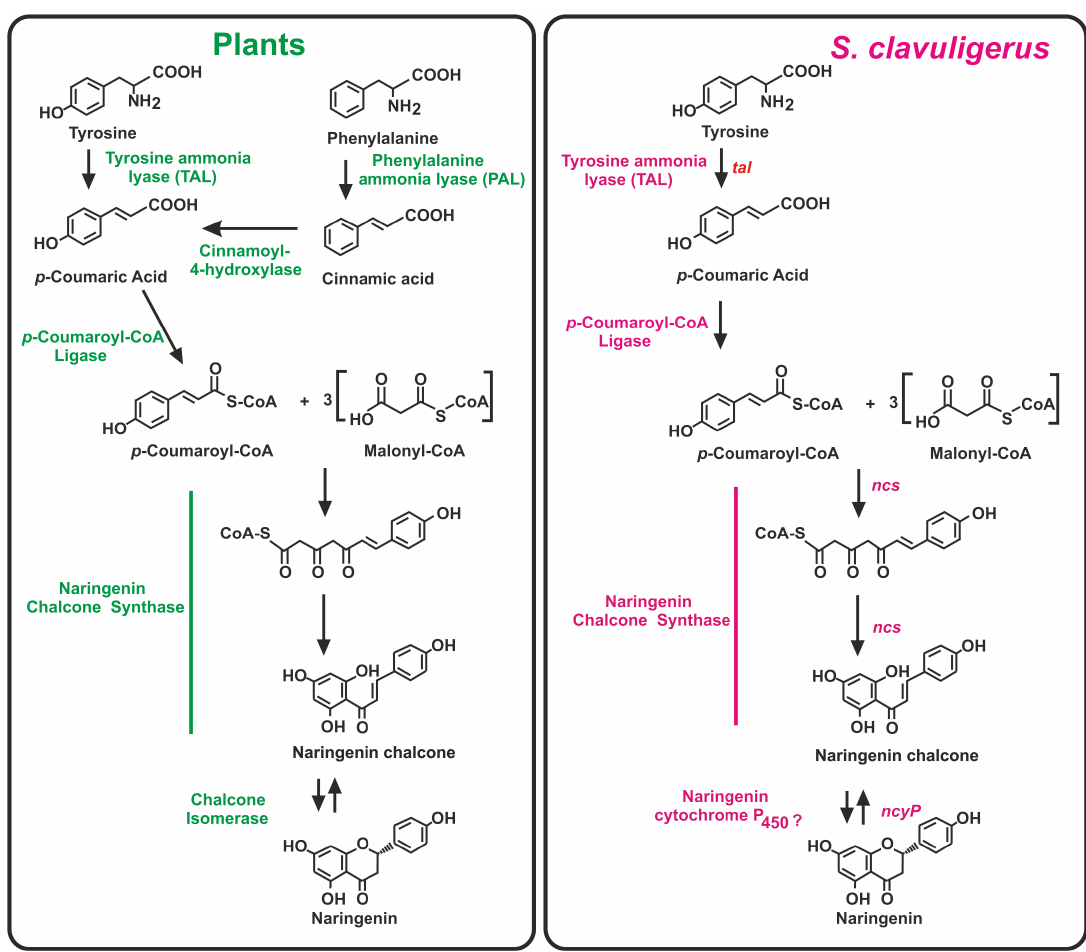
Figure 2. Biosynthetic pathway of naringenin in plants (green letters, left panel) and in Streptomyces clavuligerus (red letters, right panel). The starter units and the intermediates are indicated below the structures. The enzymes involved in every step of the pathway are labelled in colour. Note that either tyrosine or phenylalanine are used as precursors of the starter units in plants, but only tyrosine is used in S. clavuligerus